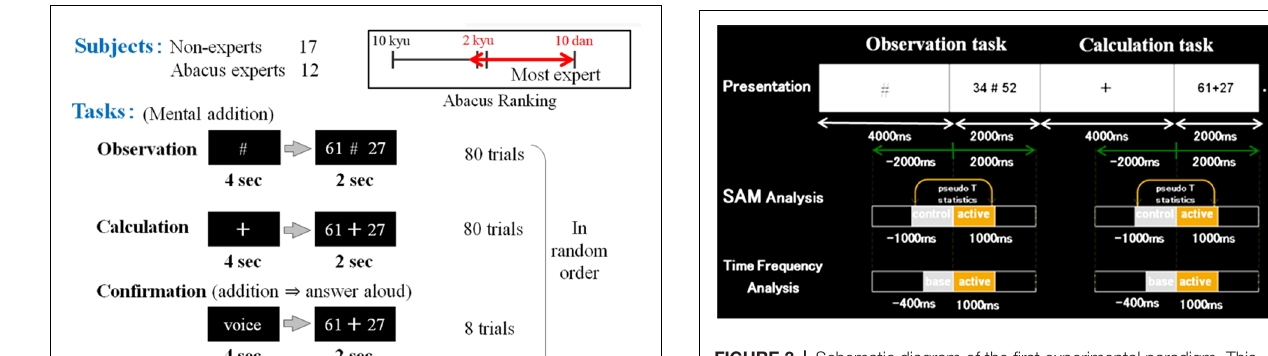
FIGURE 3 | Schematic diagram of the first experimental paradigm. This figure shows a schematic diagram of the task presentation, and a time window of synthetic aperture magnetometry and time-frequency analyses. First, in control stimuli, we presented “+” or VOICE for 4 s, which means what the subject should do in active stimuli. Then, in active stimuli, numbers for calculation were presented for 2 s. In SAM analysis, we compared 1 s before and after the presentation of numbers. Also, regarding time-frequency analysis, the baseline was set for 400 ms before the number